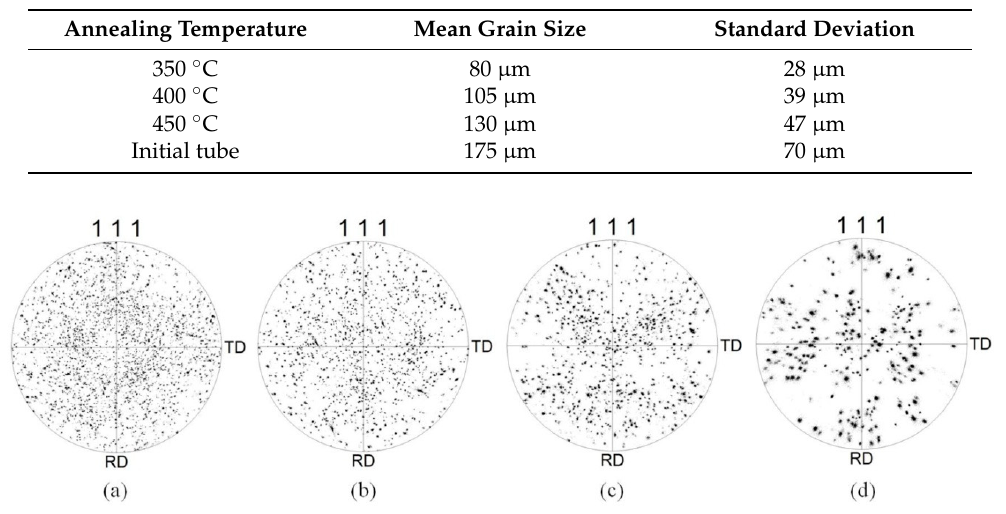
Figure 4. Grain orientation distributions of spun tube after annealing at ( a ) 350; ( b ) 400 and ( c ) 450 °C for 1 h; and ( d ) that of the initial tube.